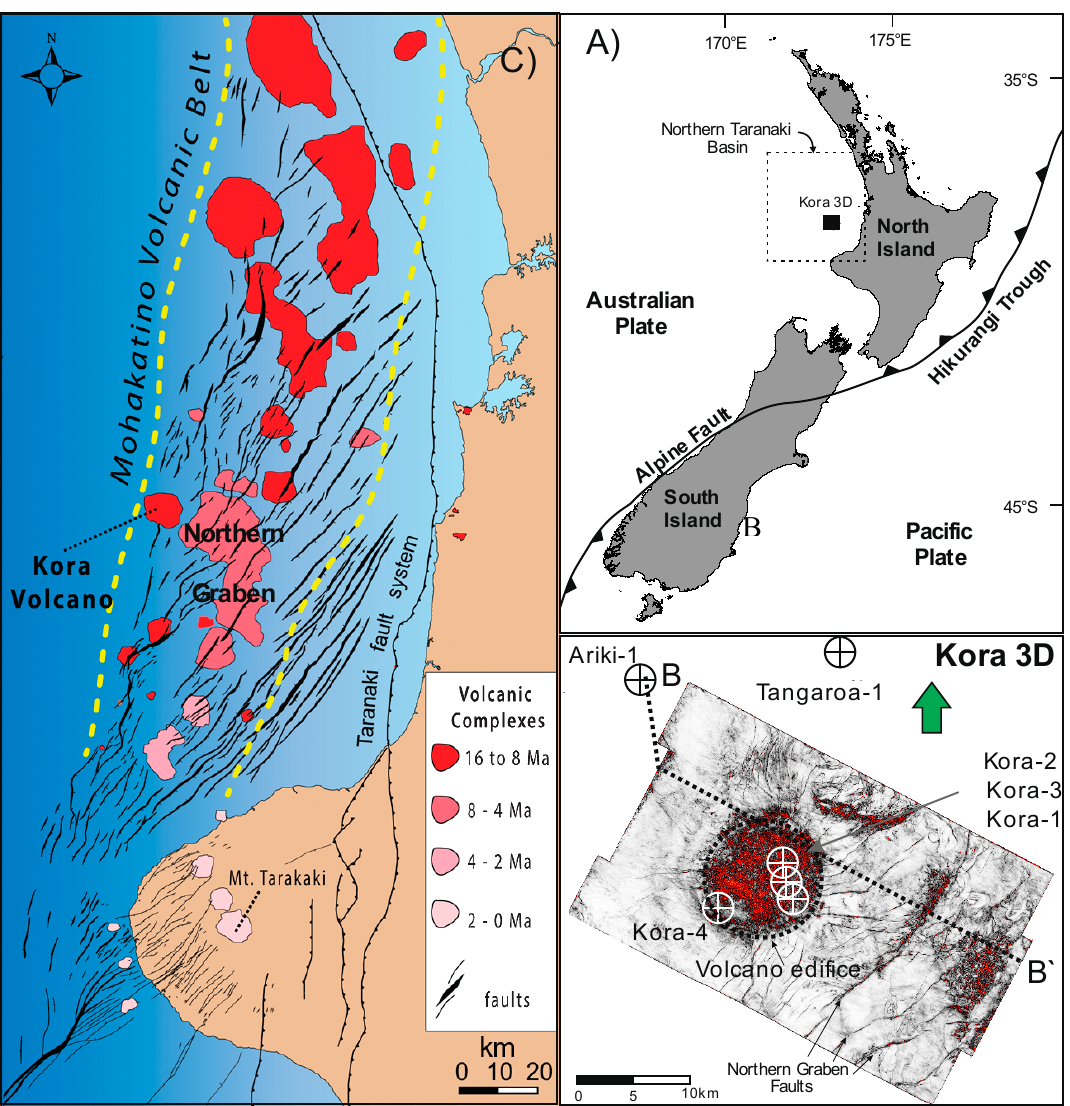
Figure 1. ( A ) Location map of the study area (marked in black box in the center of the northern Taranaki Basin). ( B ) Time slice at 1984 ms through the variance seismic attribute showing Kora volcano edifice, several Northern Graben faults, and the location of the wells used in this study. ( C ) Map of the northern Taranaki Basin illustrating the volcanic complexes and location of the Kora volcano (modified after Giba et al. [22] and Bischoff et al. [12]).